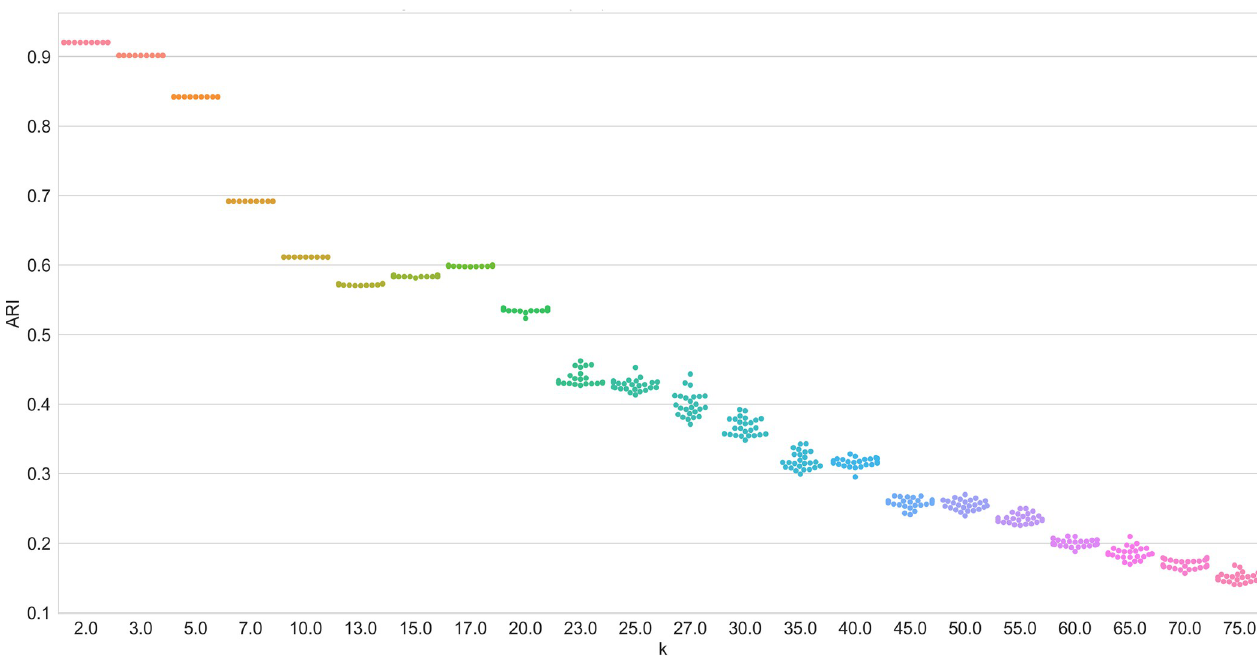
Fig 5. Algorithm performance (ARI) of NMF on the WikiA dataset